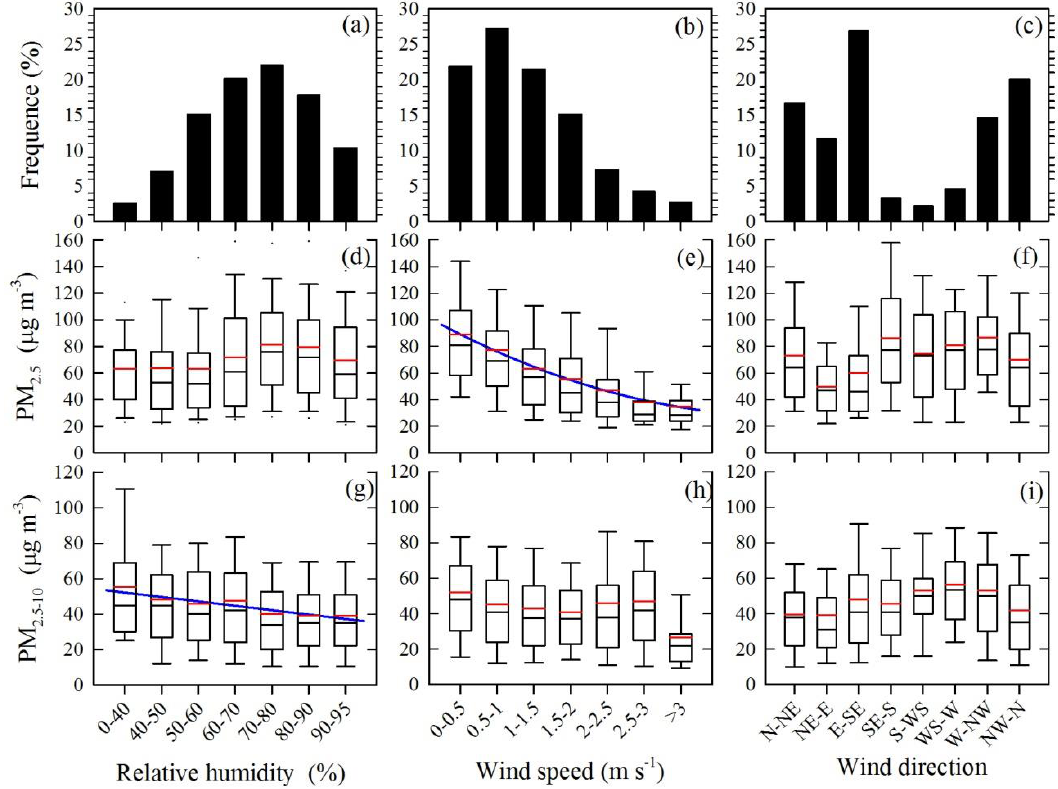
Figure 3. The occurrence frequencies of different ranges of relative humidity ( a ), wind speed ( b ), and wind direction ( c ). Box plots of the PM 2.5 concentrations at different ranges of relative humidity ( d ), wind speed ( e ), and wind direction ( f ), and the PM 2.5–10 concentrations different ranges of relative humidity ( g ), wind speed ( h ), and wind direction ( i ). The box boundaries represent the 25th and 75th percentile, the black and red horizontal lines are the median and the average, respectively.